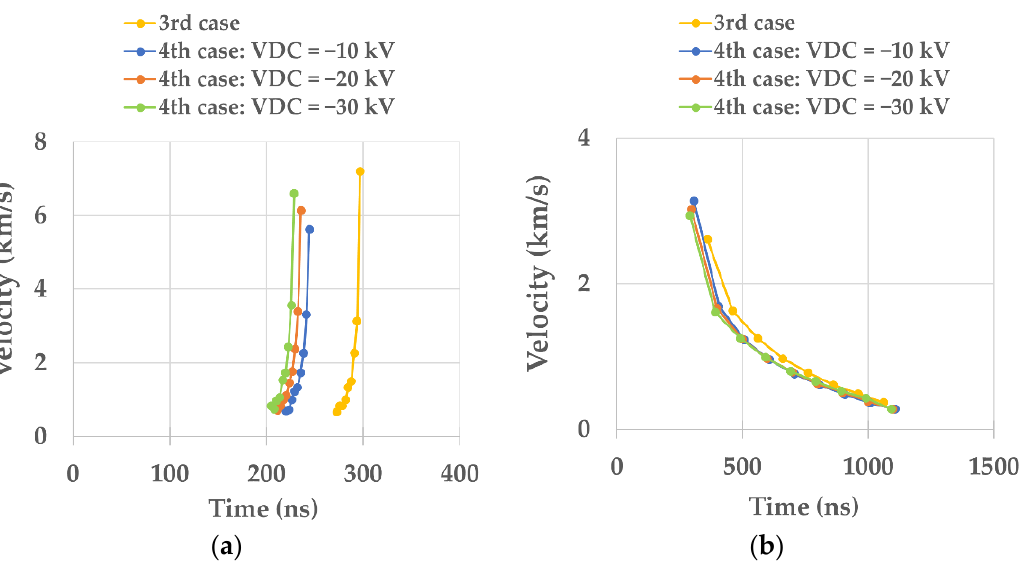
Figure 17. Streamer velocity (km/s) as a function of time (s) in the 3rd and 4th cases: ( a ) streamer propagation in oil; ( b ) streamer travel along the oil–OIP interface.